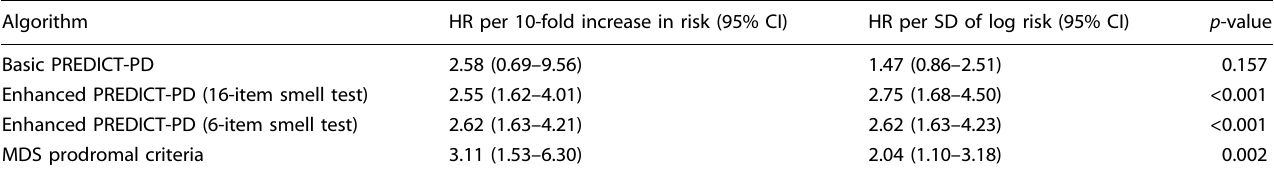
Table 3. Hazard ratios (HR) of incident PD at 6 years of follow-up for a 10-fold increase in baseline risk and a one standard deviation (SD) increase in baseline log risk according to risk algorithm.